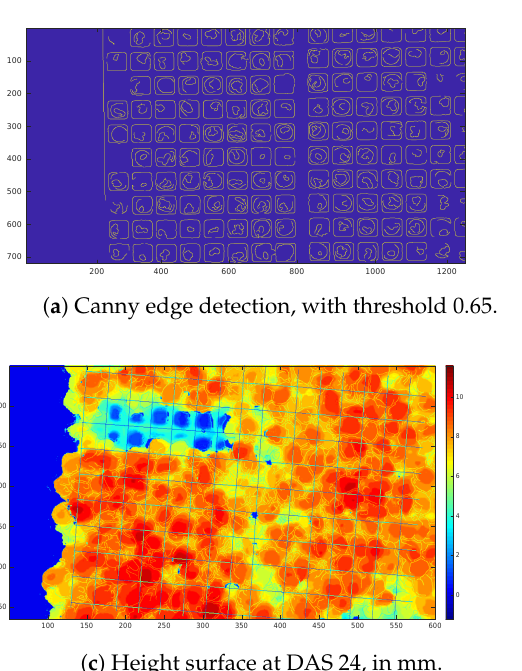
( d ) 3D reconstructed leaves with the lines separating the tray cells visible, with height in